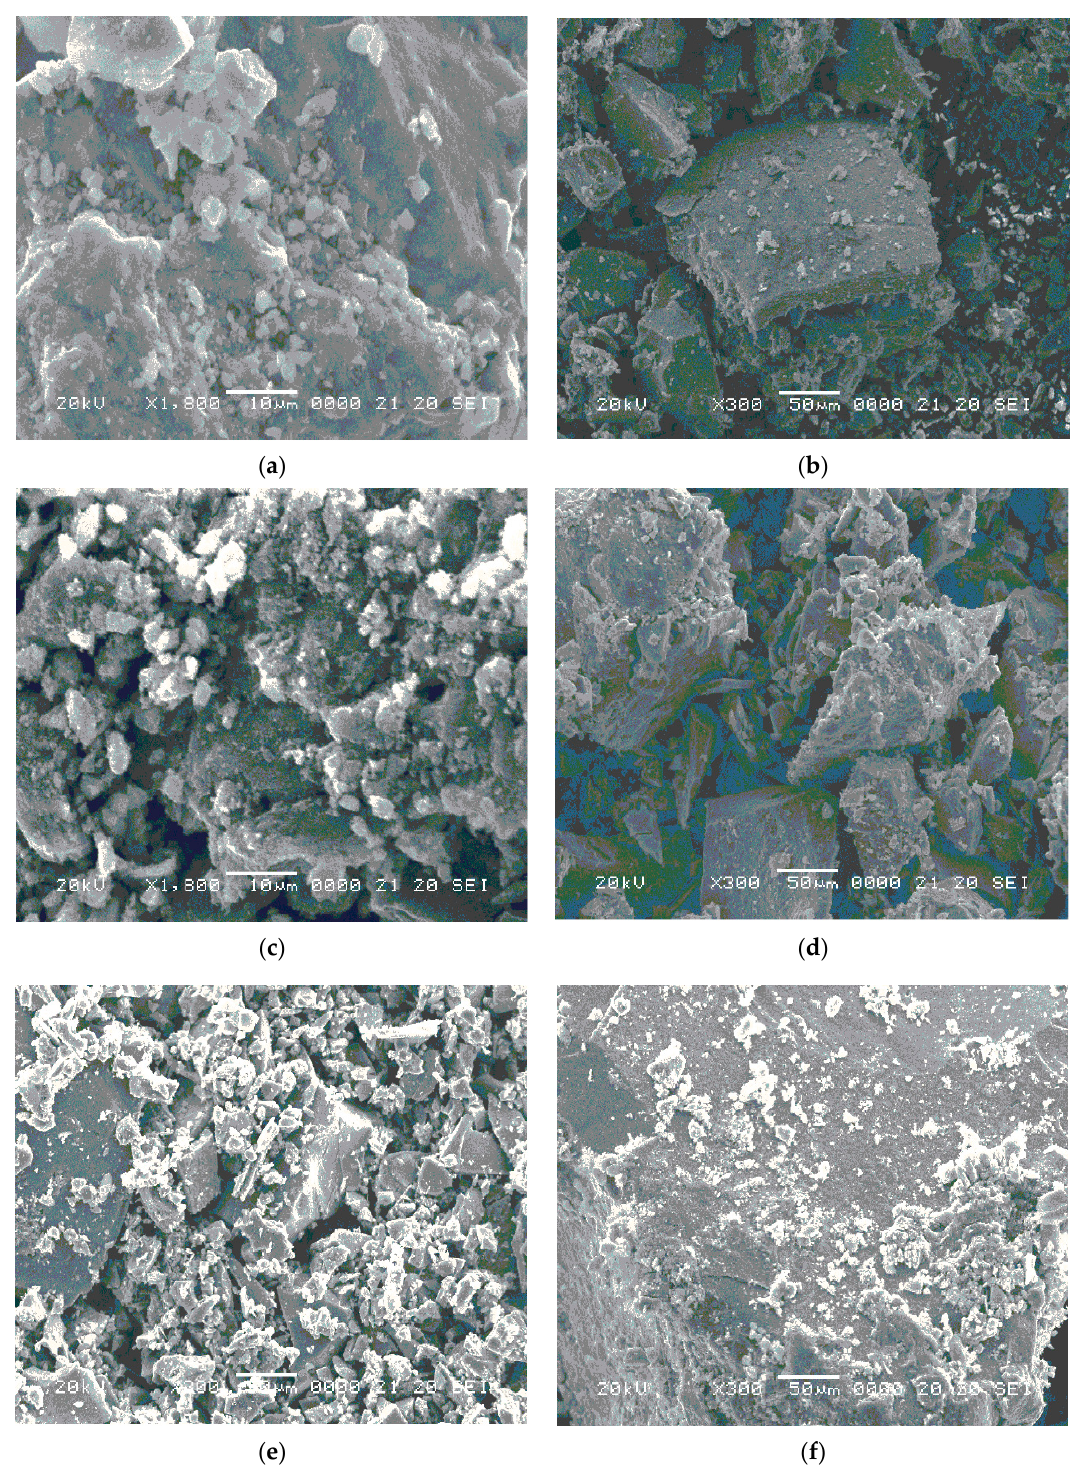
Figure 4. EM images of ( a , b ) uncoated MNPs, ( c ) lauric-acid-coated MNPs, ( d ) oleic-acid-coated MNPs, ( e ) linoleic-acid-coated MNPs, ( f ) linolenic-acid-coated MNPs. The size, shape, lattice parameter and area of bared MNPs and surfactant-coated MNPs were analyzed using XRD data by following the Scherrer equation [24]. τ = K λ / ω cos